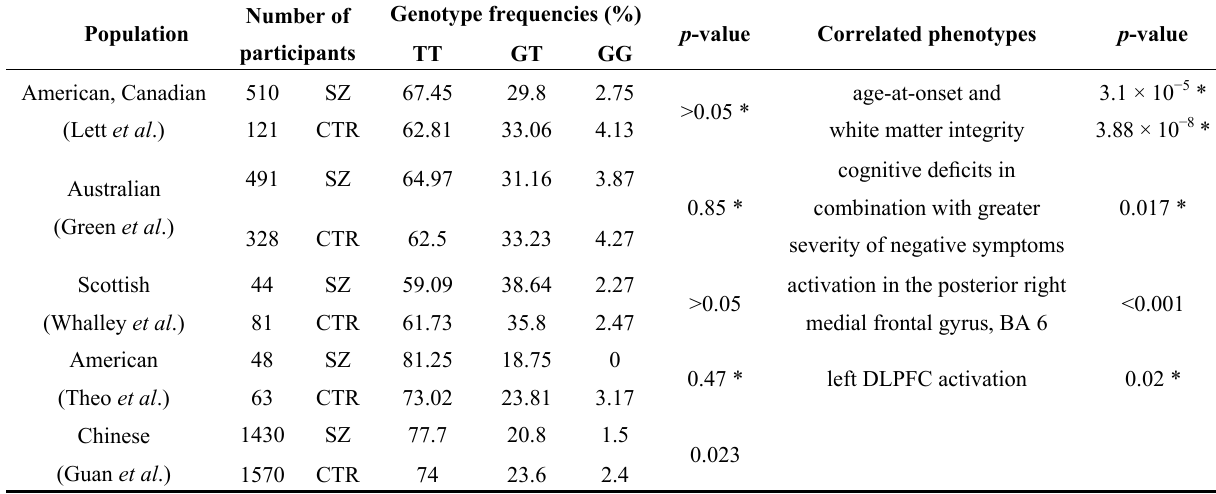
Table 1. Summary of human genetic studies linking the miR-137 rs1625579 polymorphism to schizophrenia and